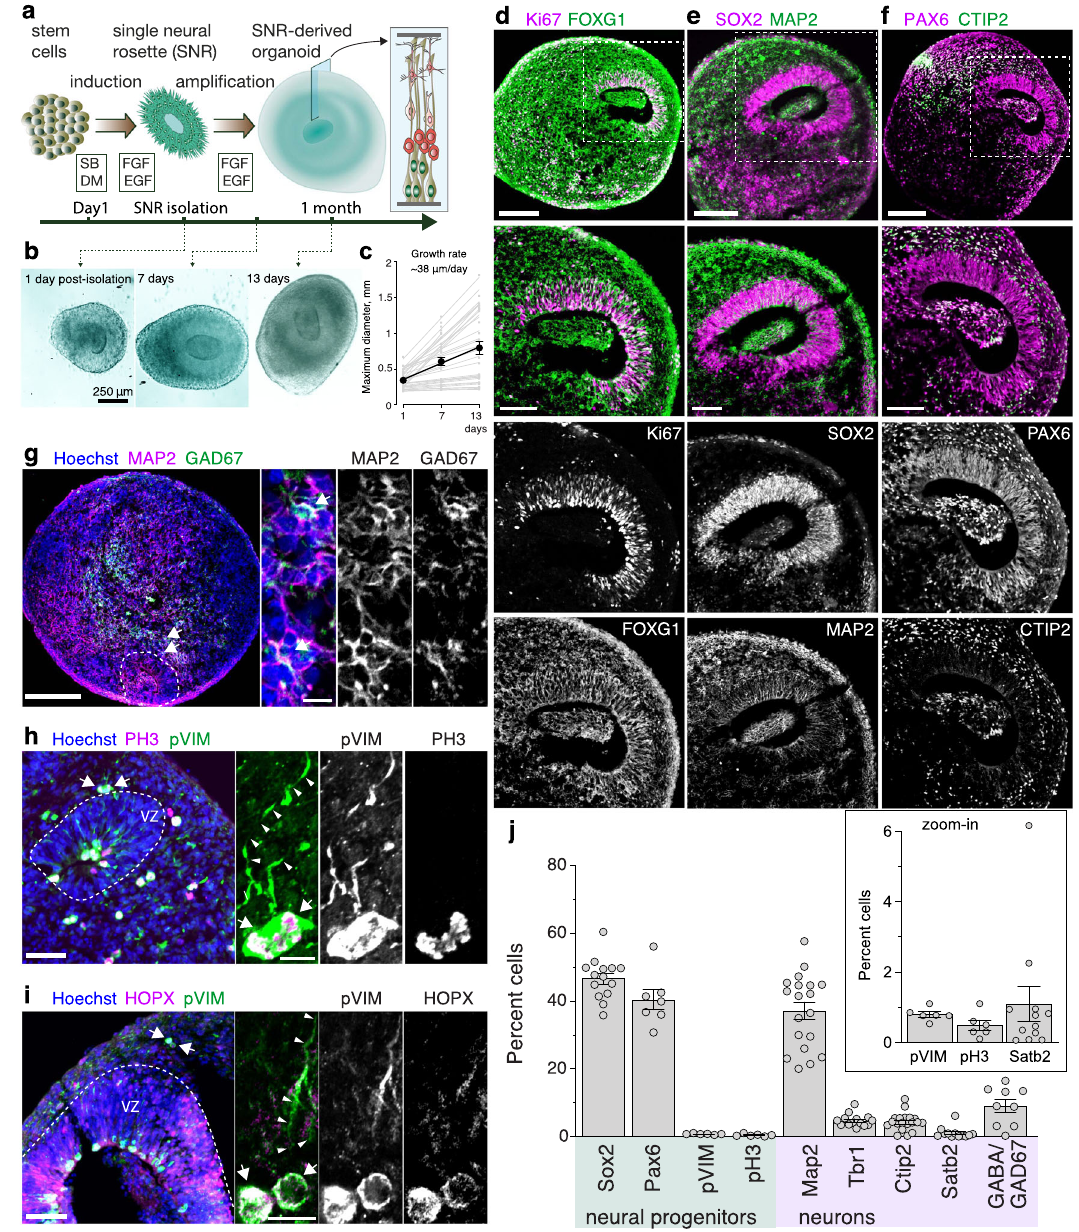
Fig.1|Generationandcharacterizationof1-month-oldSNR-derivedorganoids. a Protocol schematic (elements were drawn by Coni Hoerndli Science Design). b Images of SNR-derived organoids at days 1, 7, and 13 post SNR isolation. c Quanti fi cation of initial organoid growth ( n =32 rosettes obtained from H9 and 2242-5 lines). The line shows linear fi t of the data. d – i Images of organoid sections immunostained for FOXG1 and Ki67 ( d ), SOX2 and MAP2 ( e ), PAX6 and CTIP2 ( f ), MAP2andGAD67( g ),PH3andpVIM( h )HOPXandpVIM( i ). j Quanti fi cationofcells